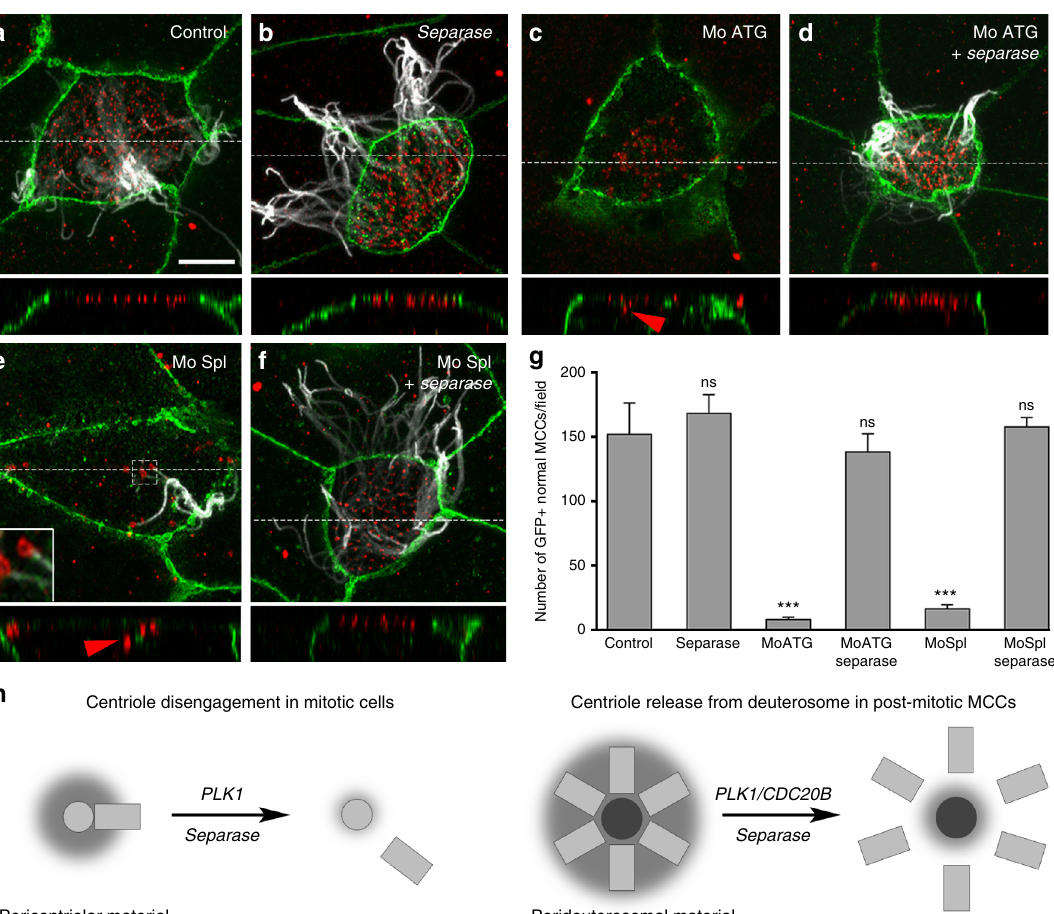
Fig. 7 Separase overexpression rescues multiciliogenesis in absence of Cdc20b. a – f 8-cell Xenopus embryos were injected in the presumptive epidermis with GFP-gpi mRNA, cdc20b morpholinos, and human Separase mRNA, as indicated. Embryos were fi xed at tailbud st25 and immunostained against GFP (injection tracer, green), Acetylated- α -Tubulin (cilia, white) and ɣ -Tubulin (BBs, red). White dotted lines indicate the position of orthogonal projections shown in bottom panels. Red arrowheads point undocked BBs. Left inset in e shows zoom on clustered centrioles. g Bar graph showing the mean number of properly ciliated MCCs among injected cells, per fi eld of observation, with standard error mean, from two independent experiments. Counting was performed on pictures taken at low magni fi cation (×20), in order to score a large number of cells. Separase overexpression fully rescued multiciliogenesis in cdc20b morphant MCCs. One-way ANOVA and Bonferroni ’ s multiple comparisons on two experiments, *** p < 0.0001, ns p > 0.05. Scale bars: 5 µ m ( a ). h Model illustrating the analogy between centriole disengagement in mitotic cells and centriole release from deuterosomes in post-mitotic